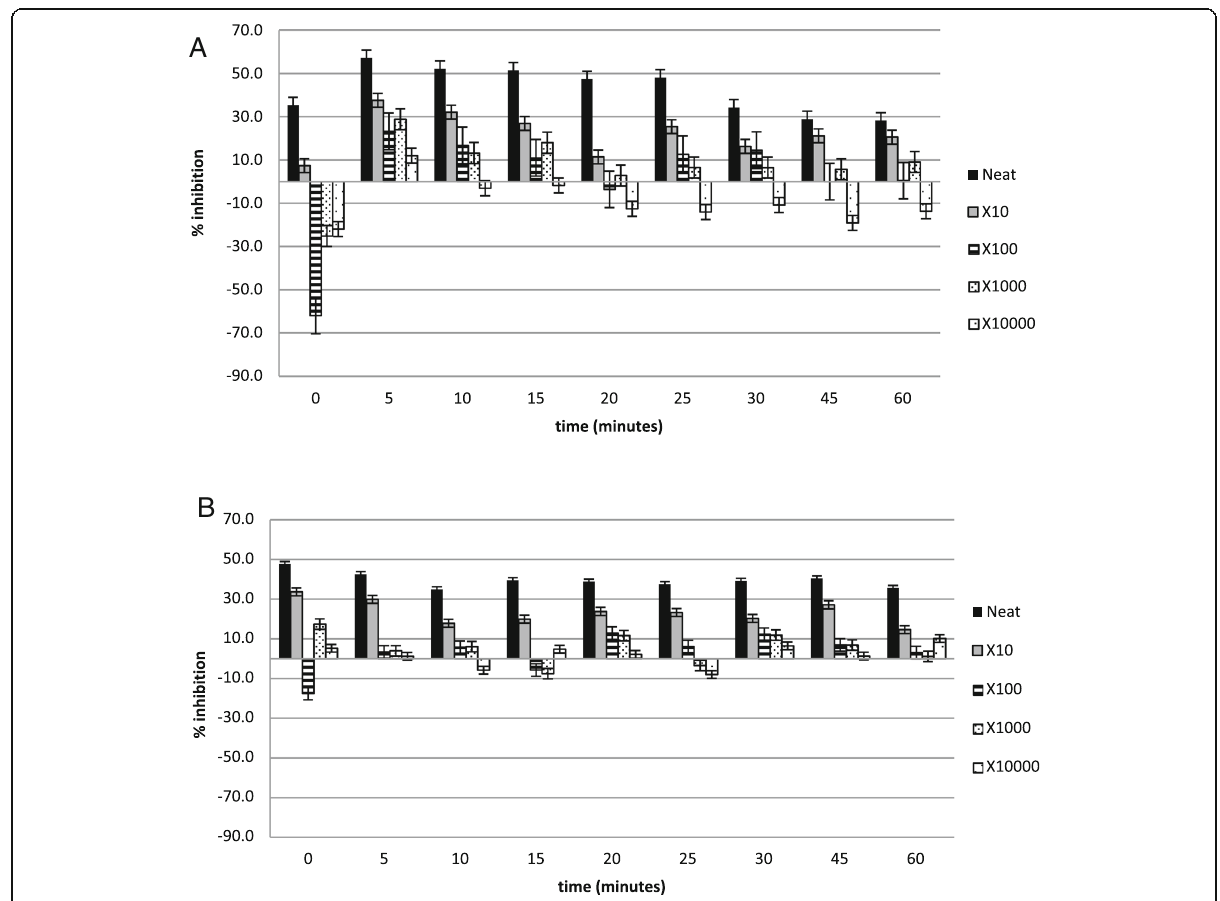
Fig. 7 The % inhibition of healthy platelets after incubation with the HM6 and diluted standards, and activation with ( a ) fMLP and ( b )